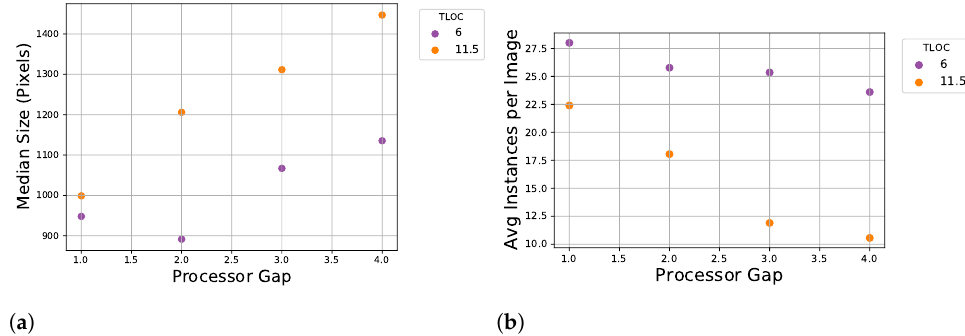
Figure 7. Statistics for annotations from 2018. Median size of annotations for sequences across PGs ( a ). Average number of annotated instance for sequences across PGs ( b ).